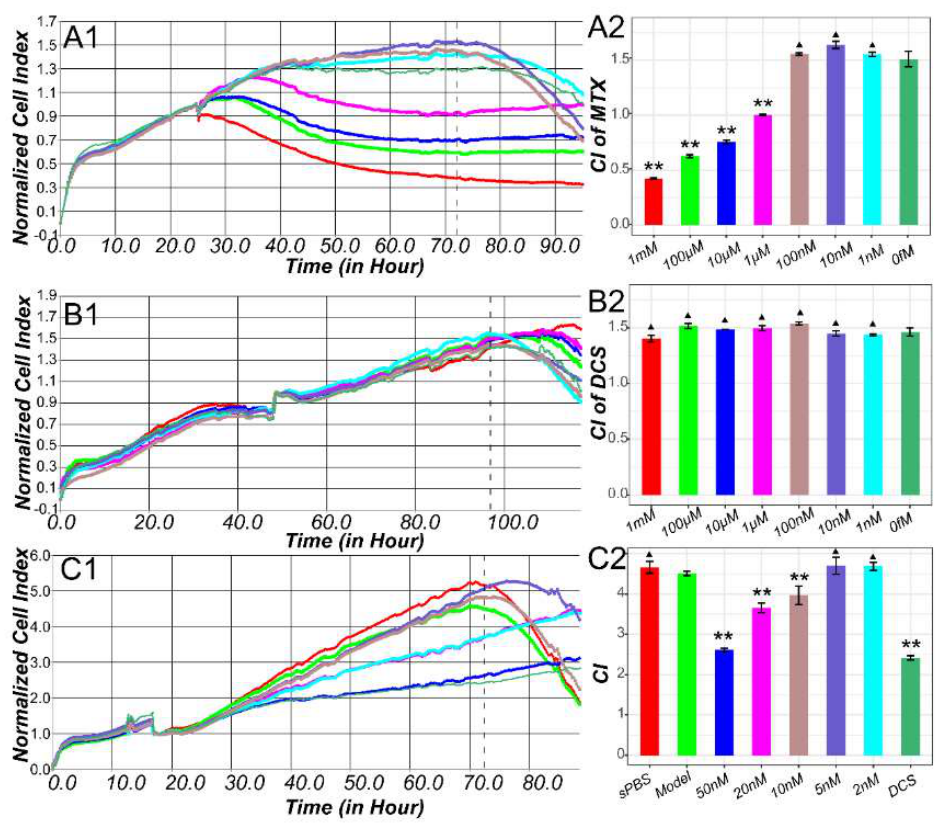
Figure 5. Proliferation curves of RAW 264.7 monitored with RTCA system and the statistic results. Cytotoxic assay of methotrexate ( A ) and Diclofenac sodium (DCS) ( B ) with a series of geometric concentrations from 1 nM to 1 mM. The treatment of methotrexate was performed at 24th h. ( A1 ) The proliferation curve of methotrexate with different dosages. ( A2 ) Statistics of cell indexes in A1 at 72nd h The treatment of DCS was performed at 48th h. ( B1 ) The proliferation curve of DCS with different dosages. ( B2 ) Statistics of cell indexes in B1 at 96th h. ( C1 ) Anti-inflammation curves of methotrexate with different dosages and DCS (1 nM). All cellular groups were treated with LPS at 12th h for 4 h. Cellular Control (Stimulated with LPS followed by PBS, sPBS) was free of LPS after the 4 h’ stimulation. The cell indexes were statistically evaluated at 72nd h. ** p < 0.01 vs. Model. ▲ p > 0.05 vs. 0 fM in A2 and B2 , vs. Model in C2 .